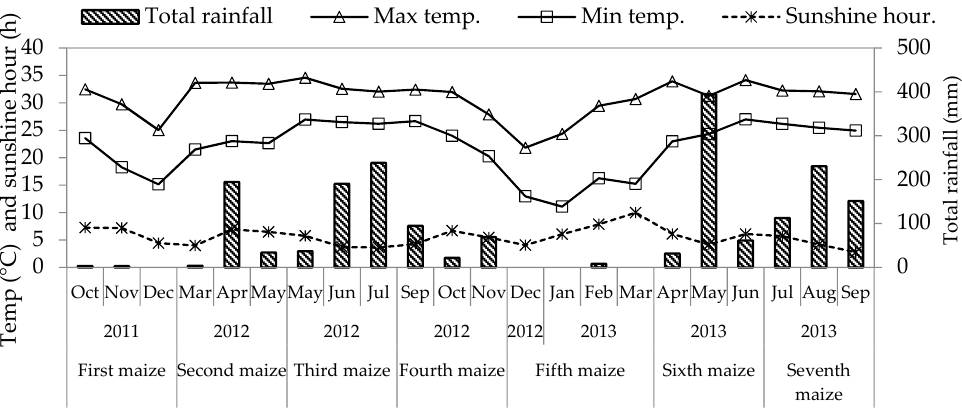
Figure 2. Mean monthly sunshine hour (h), minimum and maximum temperatures (°C), and total rainfall (mm) during successive cropping of rabi maize in pots from 2011 to 2013 in Gazipur, Bangladesh.